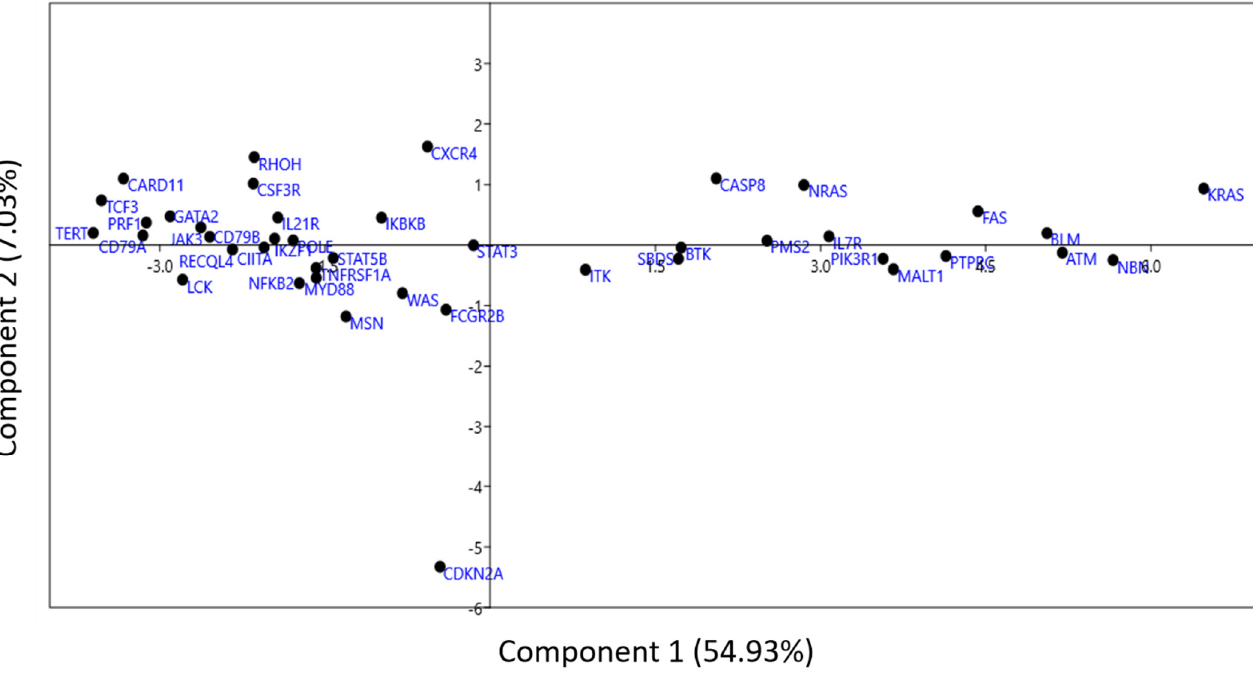
Figure 8. PCA analysis using RSCU values as 59 independent variables. Each dot corresponds to the position of a gene across axis 1 and 2. Each black dot represents a gene. Besides the dot, the name of the gene has been written in blue